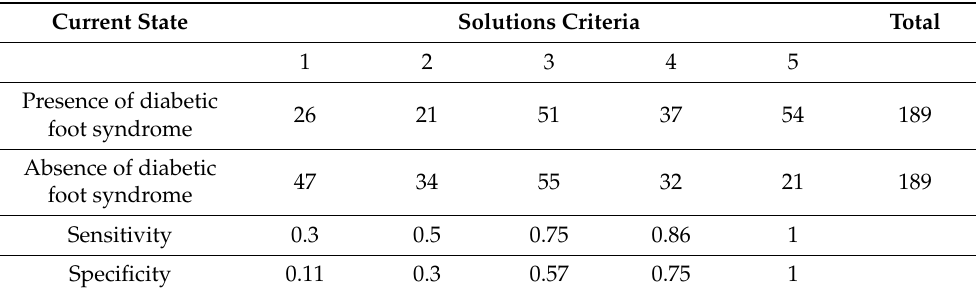
Table 2. Evaluation of the effectiveness of ICD-10 to reflect the presence of the diabetic foot syndrome in the patient’s diagnosis.